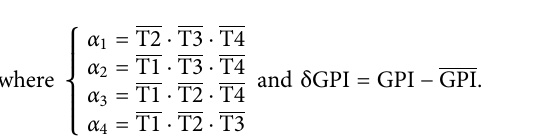
Frontiers in Earth Science |